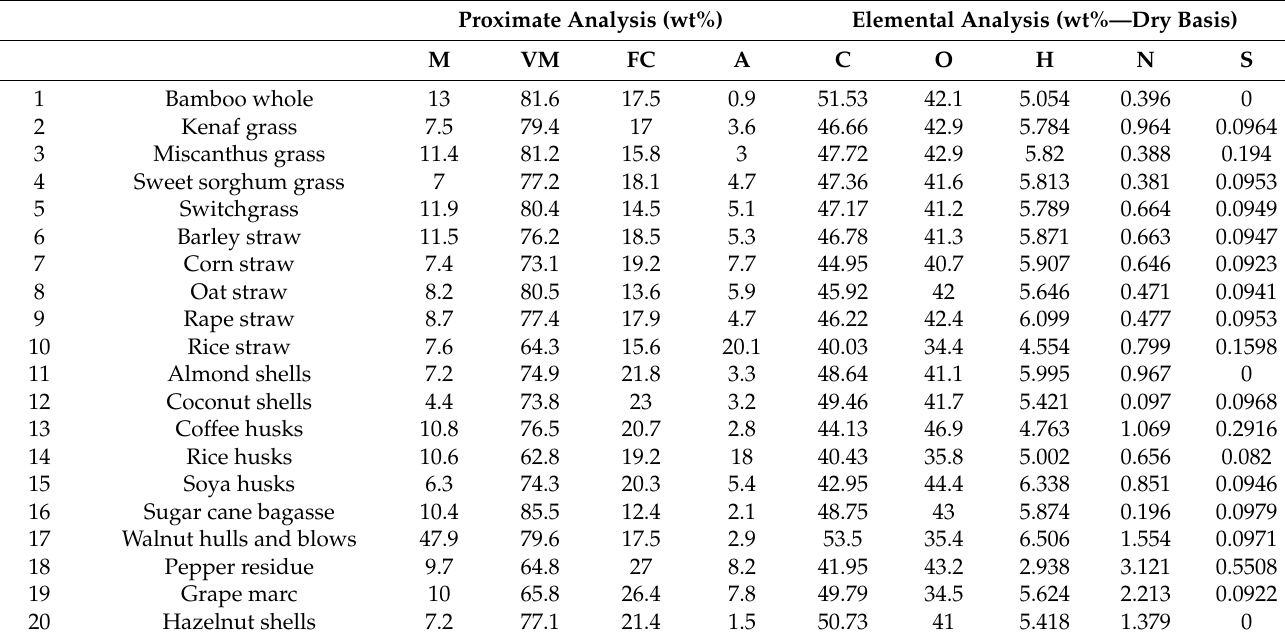
Table 1. Elemental and proximate analyses of 29 herbaceous and agricultural biomasses. M: moisture; VM: volatile materials; FC: fixed carbon; A: ash; C: carbon; O: oxygen; H: hydrogen; N: nitrogen; S: